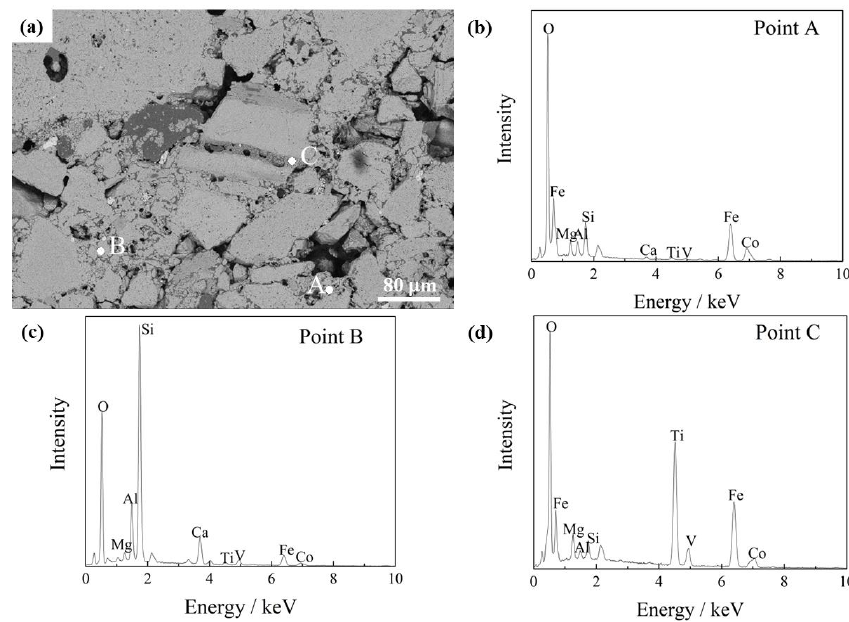
Figure 9. SEM-EDS analysis of CVTP with 6 wt % Co 2 O 3 addition: ( a ) 6 wt %, ( b ) point A, ( c ) point B, and ( d ) point C.